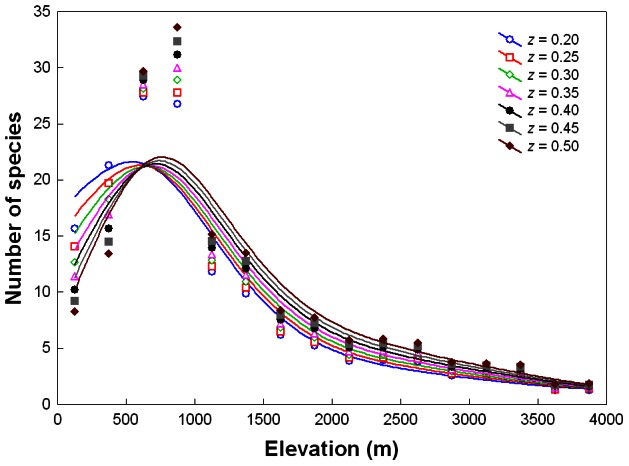
Area-controlled relationships between phanaeine species richness and elevation for different slopes (z-values) of the species-area relationship in log-log space.Curves are based on the interpolated number of species and area of each elevational zone in Bolivia, setting area to 50 000 km2. Curves were fitted by distance-weighted least squares smoothing.